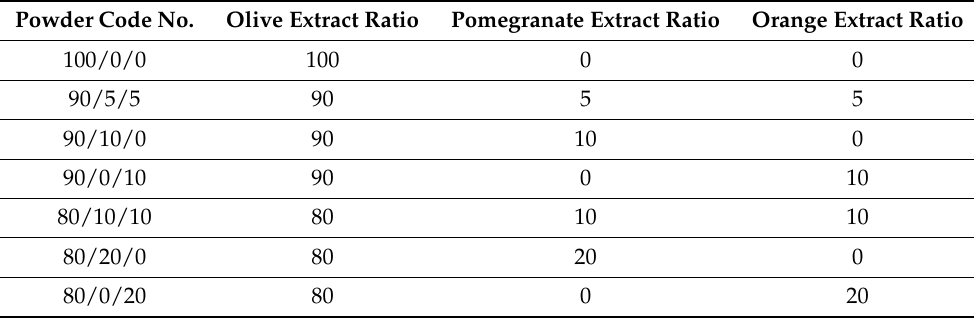
Figure 5. Industrial ultrasound homogenizer, Hielscher model UIP1000hdT ( left ) and industrial freeze dryer Zirbus GmbH model EKS 100-109 ( right ). Table 3. Coding of samples of selected antimicrobial powders and relative ratio (%) of the three different extracts of olive, pomegranate, and orange.